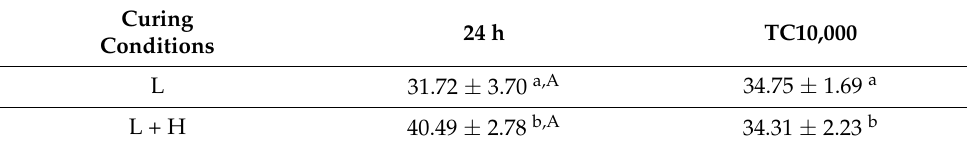
Table 2. Ultimate tensile strength of the UDMA based material used in this study. Curing Conditions